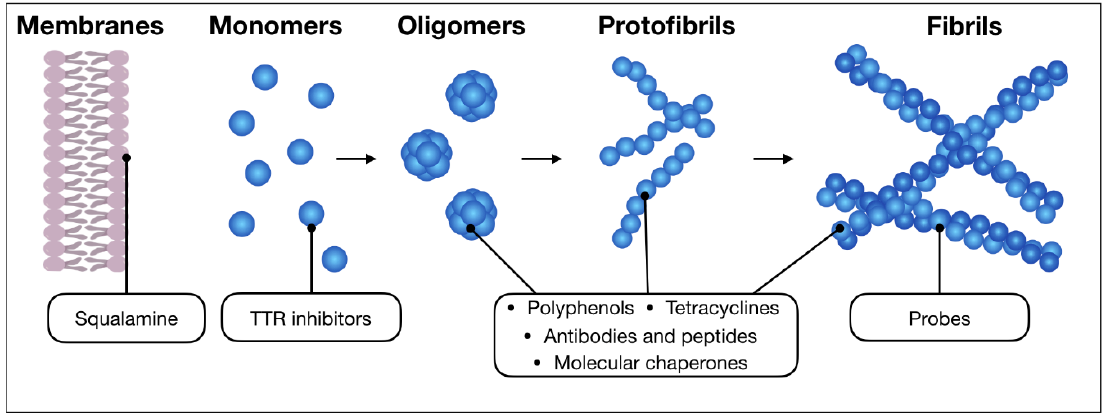
Figure 1. Schematic representation showing the intermediates of a generic amyloid aggregation pathway (monomers, oligomers, protofibrils and fibrils). The scheme includes a membrane as well, which in some cases can play a role in the process, such as for α -syn. In the figure, the main classes of anti-aggregation molecules discussed in this review are connected to the aggregated species to which they have been reported to preferentially bind.